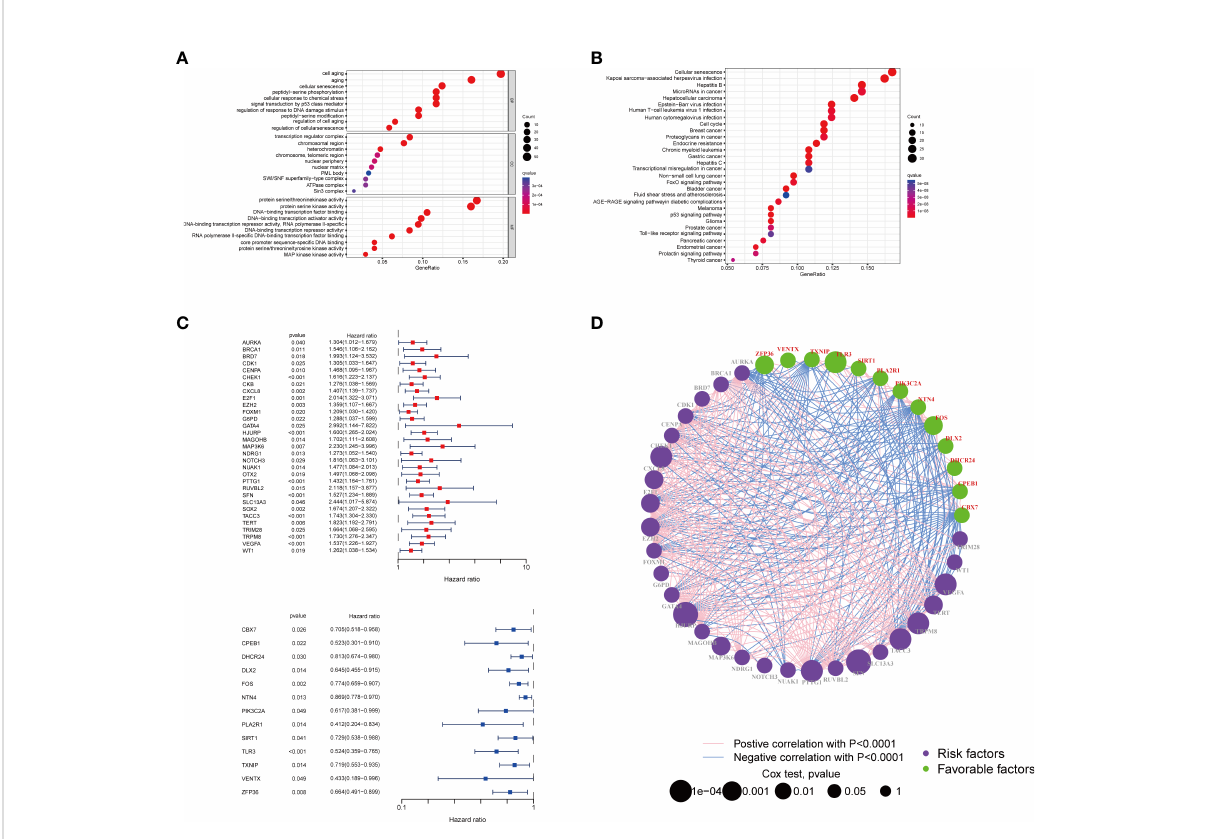
FIGURE 1 Enrichment analysis of the differently expressed genes and the PPI of the two groups. The bubble plot of the biological process (A) and pathways (B) enriched between the two subtypes. (C) The forest plot of the survival analysis of the senescence-related genes. (D) Interactions among senescence-related genes in BRCA. The line connecting the senescence-related genes represents their interaction, with the line thickness indicating the strength of the association between senescence-related genes. Green and pink represent negative and positive correlations, respectively. PPI, protein – protein interaction; BRCA, breast